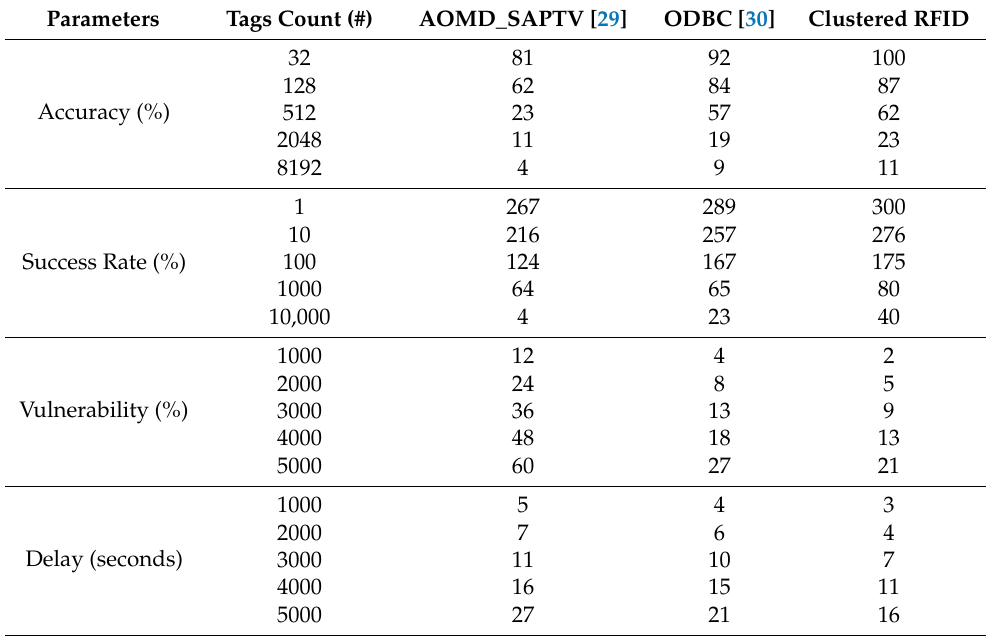
Table 2. Comparison between Clustered RFID, AOMD_SAPTV, and ODBC.